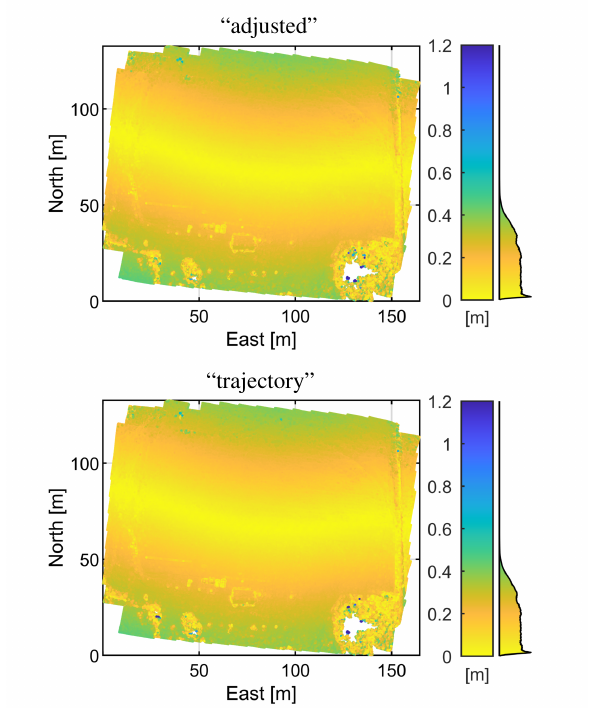
Figure 6. Cloud-to-cloud distances of the “adjusted” and “telemetry” point clouds with respect to the reference one. On the right side of each colourbar, the histogram showing the distance distribution is depicted. The colourbar is saturated to 1 . 2 m (disregarding less than 1% of the points in both